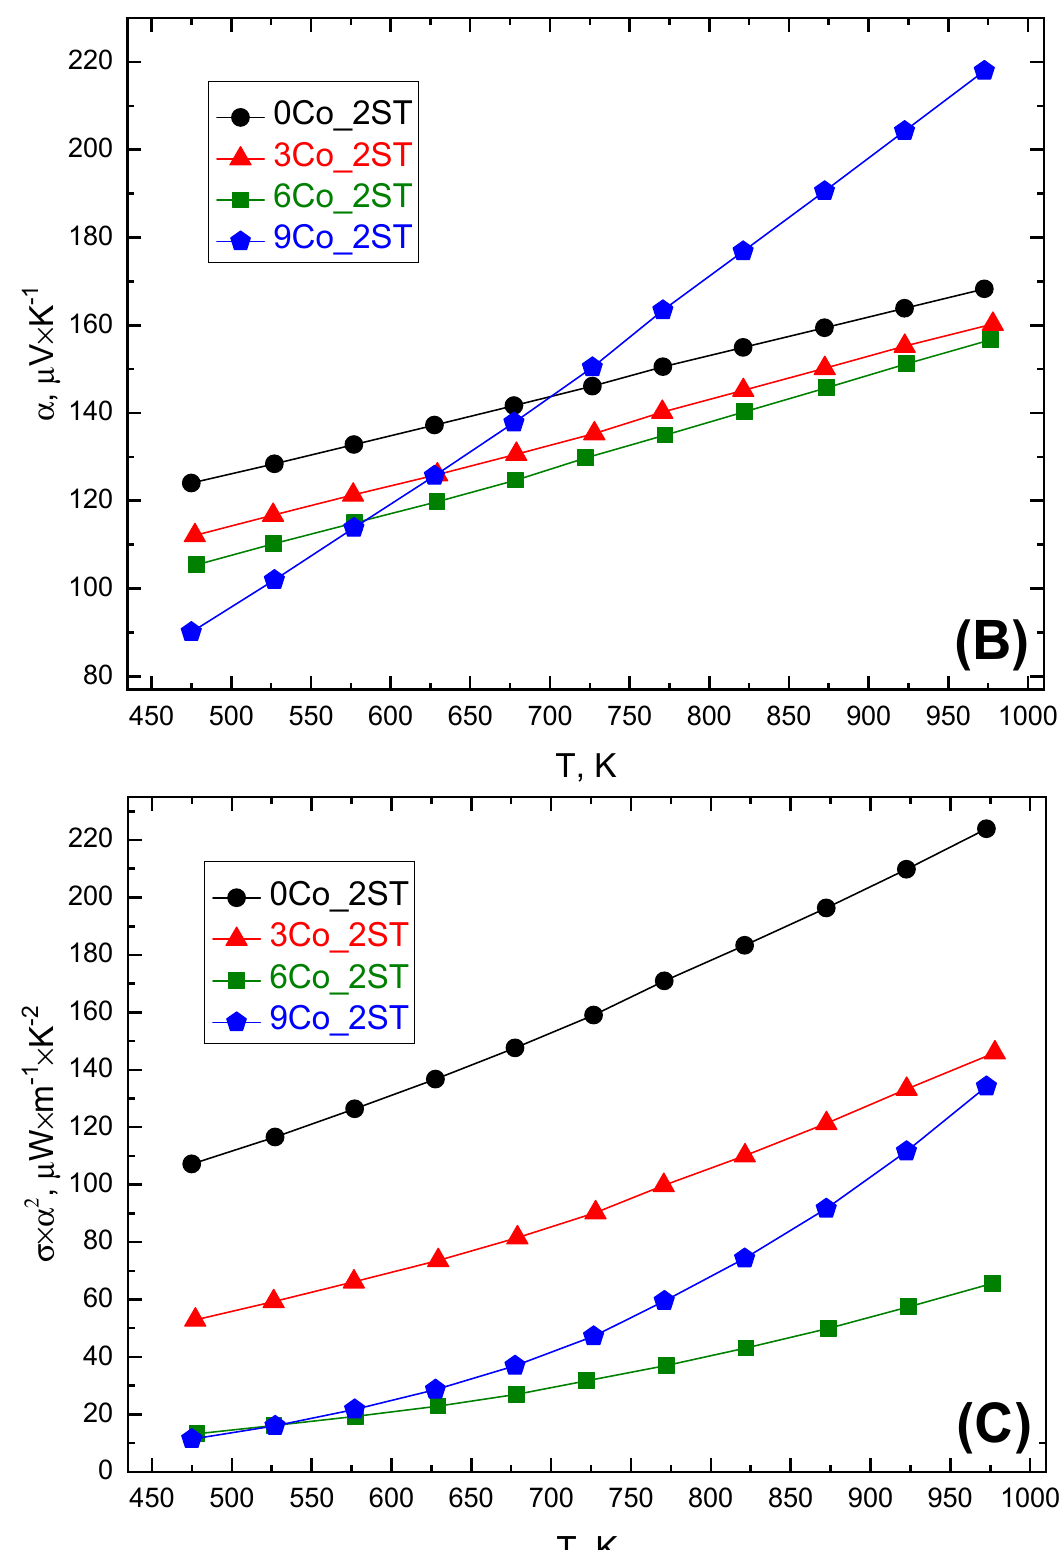
Figure 6. Electrical conductivity ( A ), Seebeck coefficient ( B ) and power factor ( C ) for 2ST sintered samples.